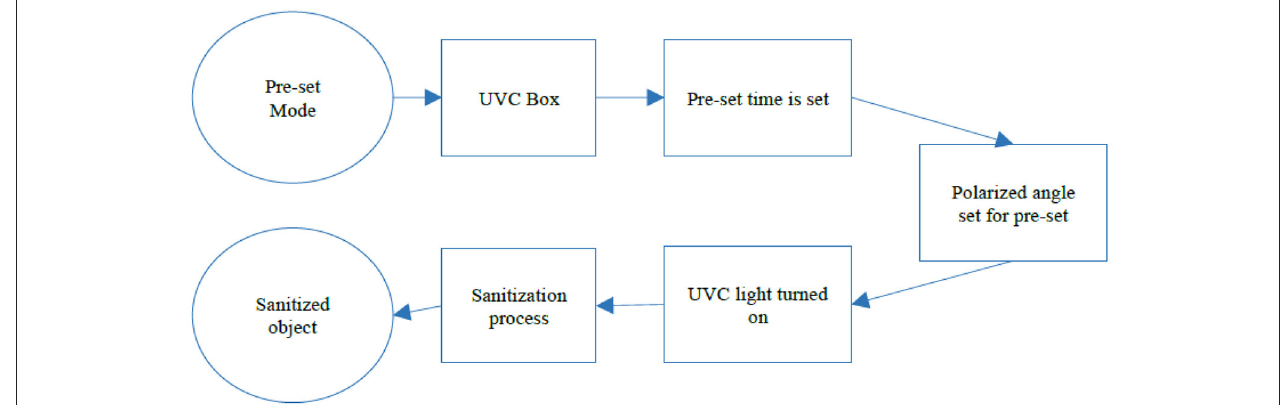
FIGURE 3 | Pre-set mode operation of UVC sanitization.